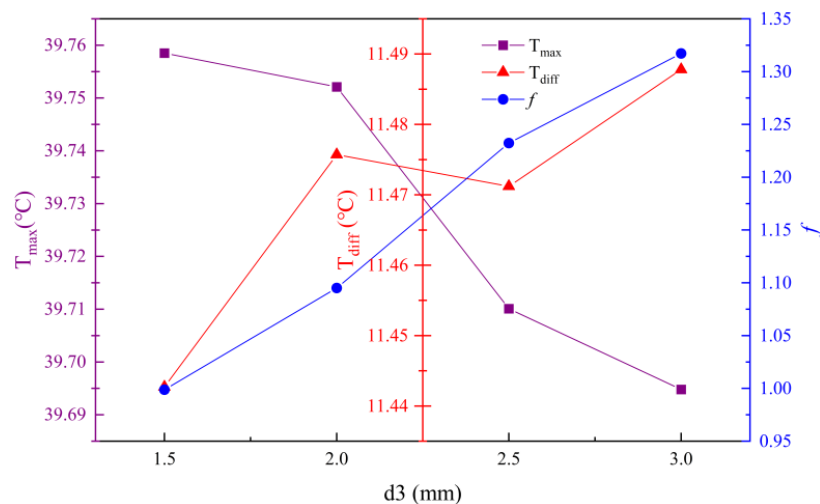
Figure 18. Influence of d 3 on evaluation indexes.